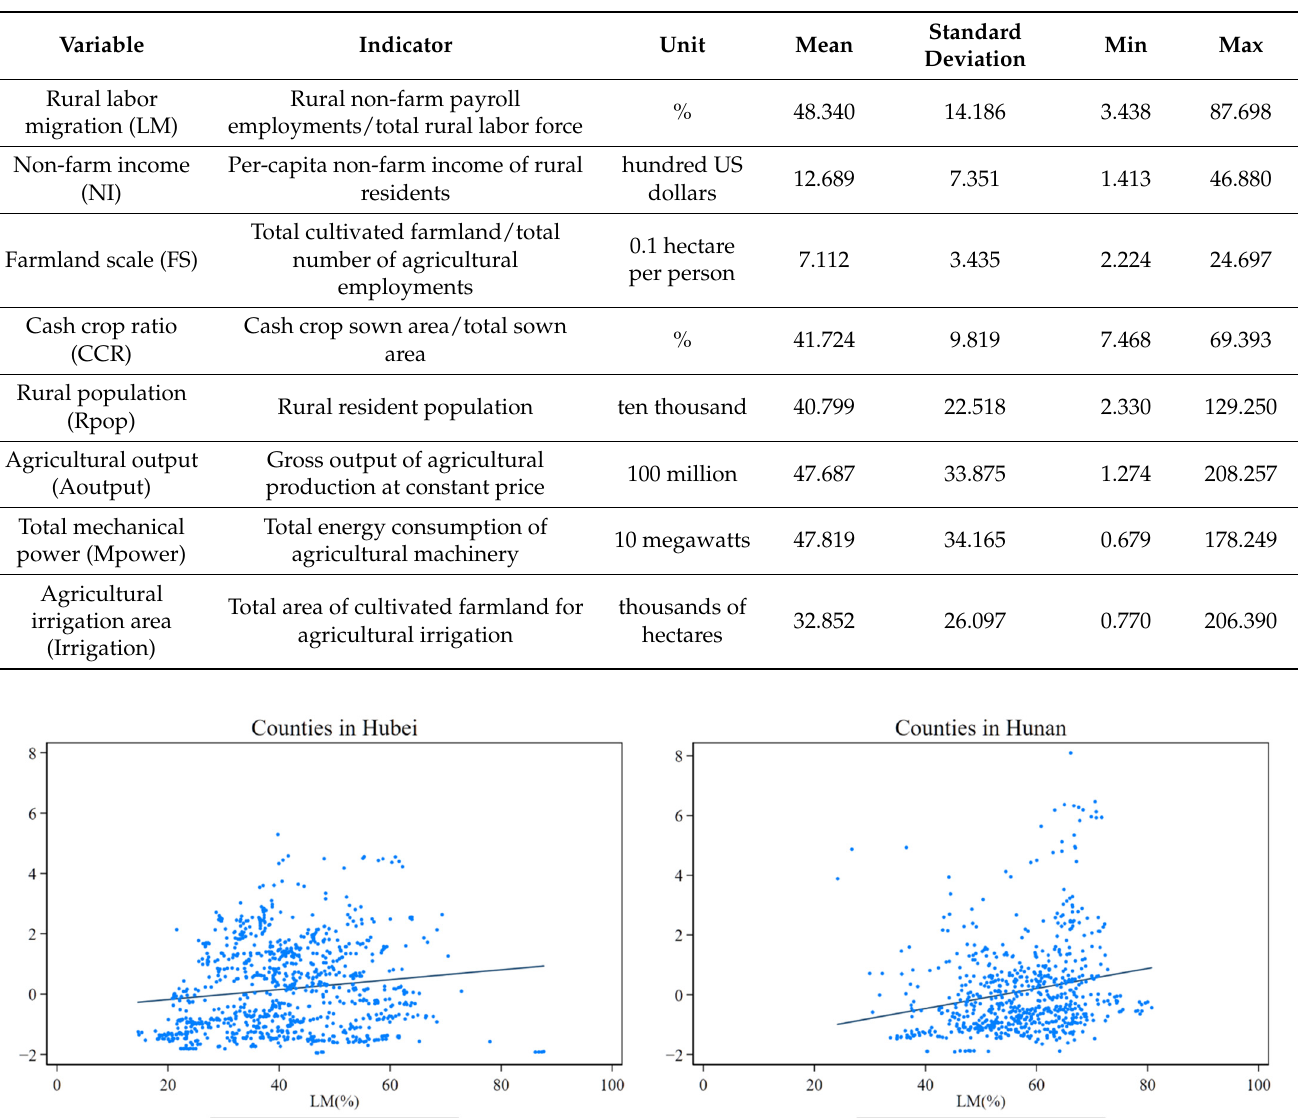
Table 1. Variables setting and statistical description.